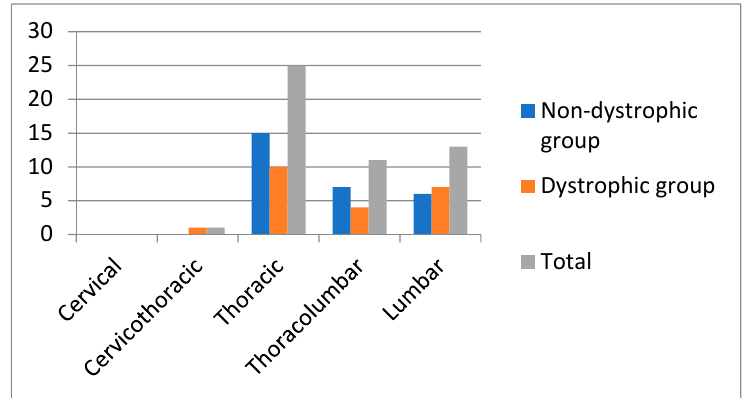
Figure 2. Distribution of scoliotic curves in the two groups of patients.